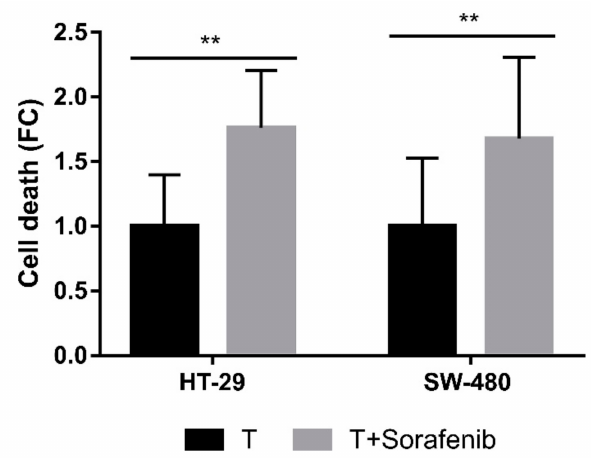
Figure 10. BRAF role in HT-29 resistance to CLytA-DAAO-induced cell death. HT-29 cell line was treated with CLytA-DAAO and D-Ala (T) in the presence or absence of sorafenib for 24 h and cell death was determined by flow cytometry. Data represent the cell death increase ± SD with n ≥ 3. ** indicates a p -value <